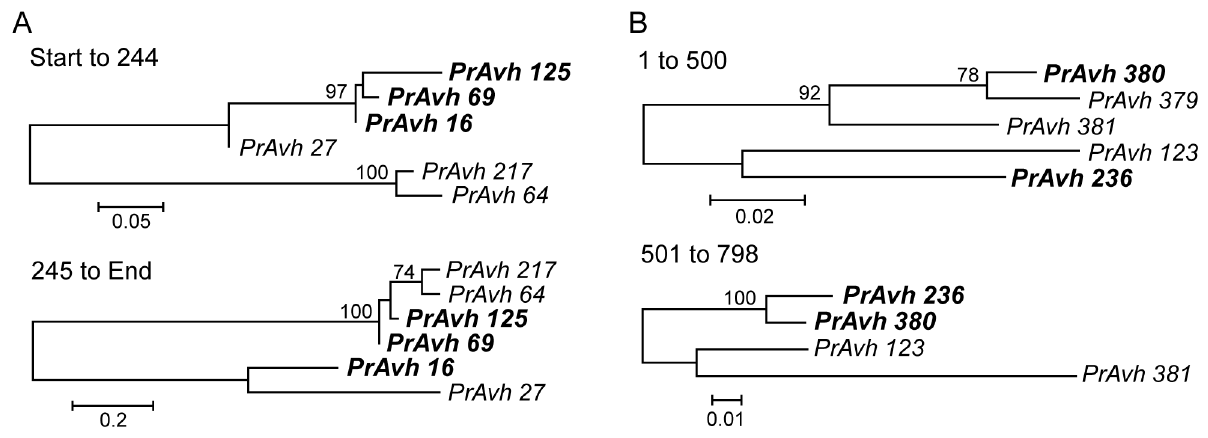
Figure 3. P. ramorum RXLR effector gene families exhibiting strong evidence of recombination. Changing evolutionary relationships in different regions of genes illustrate recombination among paralogs. Maximum likelihood trees were constructed for gene fragments on either side of estimated recombination breakpoints inferred using RDP. Bootstrap support for branches is out of 100 samples. The branch lengths are drawn to scale and measured in the number of substitutions per site. A. The phylogenetic relationships among genes in this gene family change between the N- and C-terminal coding regions of the gene. The recombination breakpoint is in the DEER motif. B. Recombination in the C-terminal functional region. PrAvh379 has a frameshift mutation leading to a 507 bp truncated gene and thus is not included in the second tree. doi: